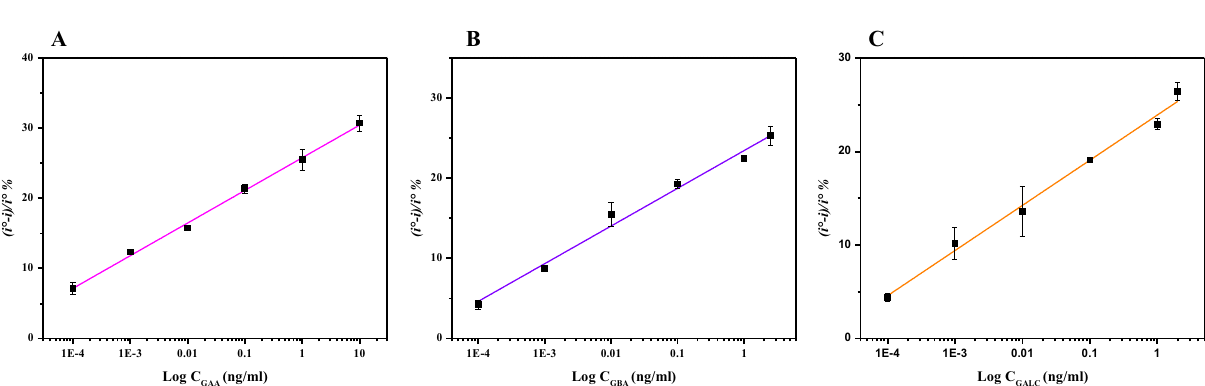
Figure 4. SWV peaks measured before and after binding with different concentrations of GAA ( A ), GBA ( B ) and GALC ( C ).